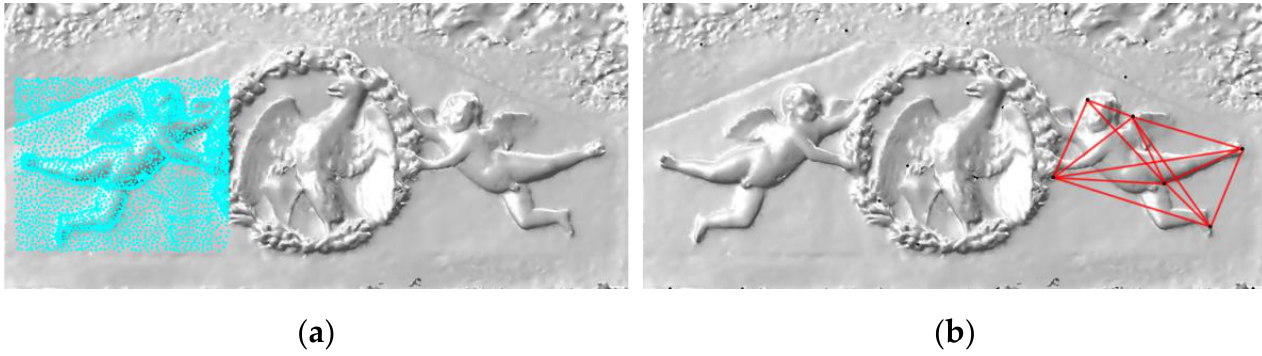
Figure 7. The cropped view of the 3D mesh with extracted matching vertices using the quantization level of 14 × 42 × 20 and tolerance 1/6: all extracted quantized vertices in this area (black markers), and matched vertices (red markers).